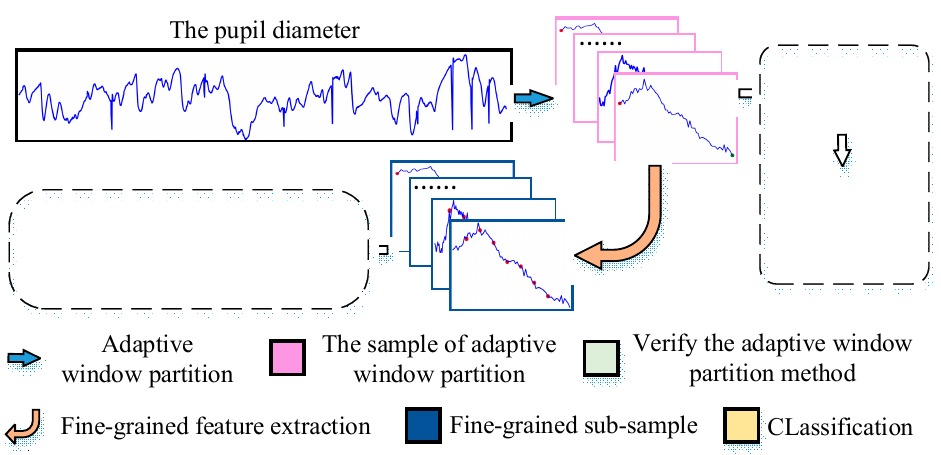
Figure 1. The overall process of our method.